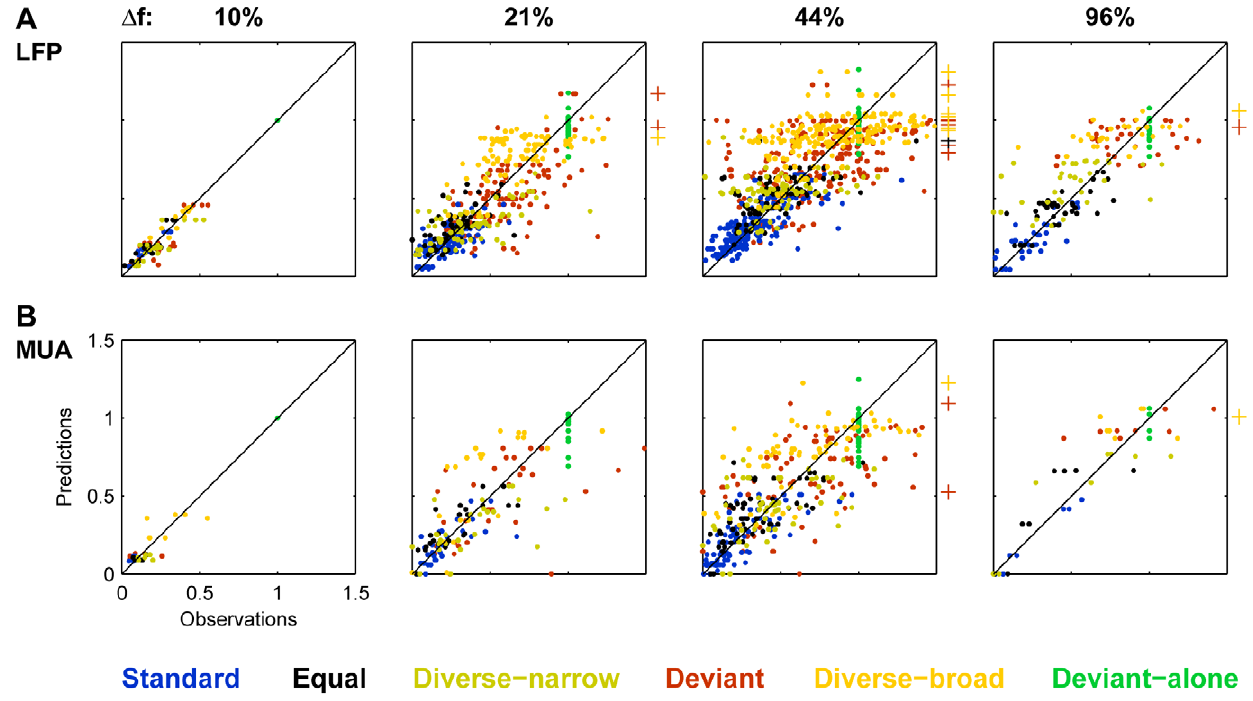
Figure 10. A comparison between the model predictions and the experimental observations. Scatter plots of all the measured responses (abscissa) versus the corresponding fits from the model based on all the data (ordinate) for each value of D f. A. LFP data. B. MUA data.